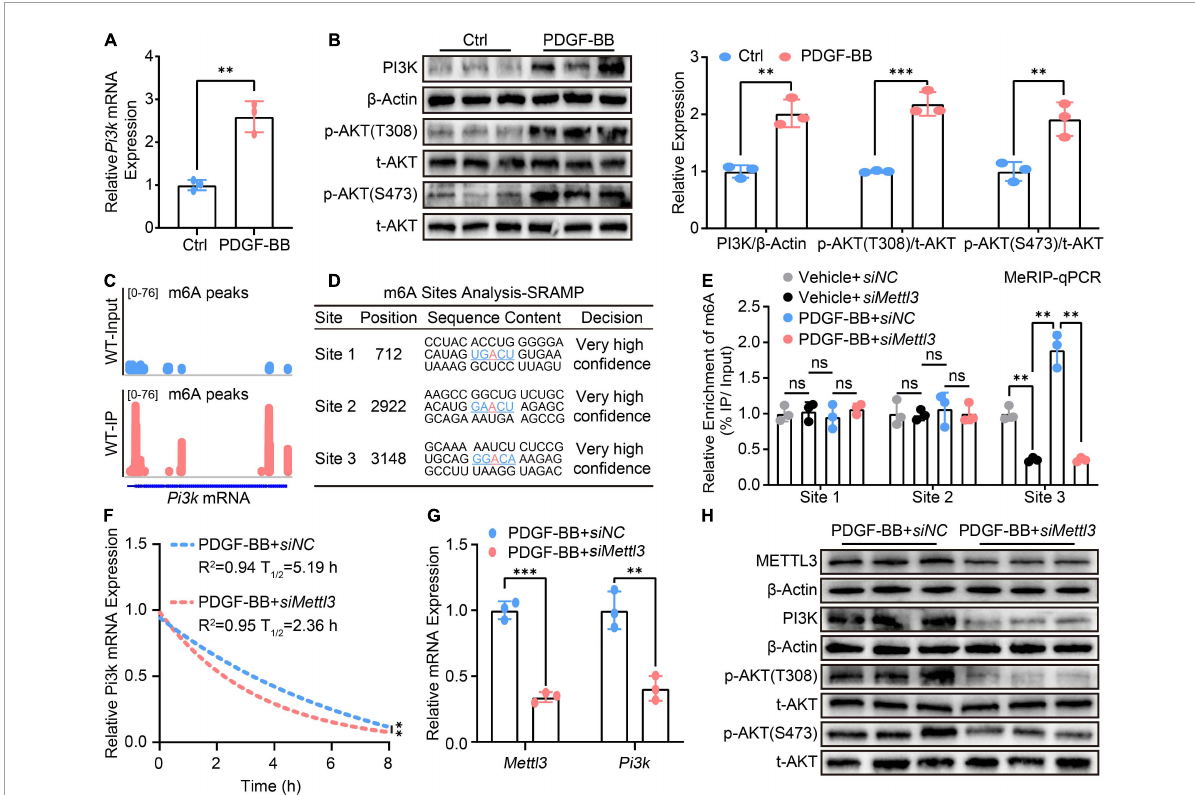
FIGURE4 Methyltransferase like 3 (METTL3)-mediated N6-methylatidine (m6A) deficiency promotes Pi3k mRNA decay thus inactivating PI3K/AKT signaling. (A) RT-qPCR quantification of Pi3k expression before and after treatment of VSMCs with PDGF-BB. (B) Representative Western Blot image and quantitative analysis of PI3K p-AKT(T308) and p-AKT(S473) levels. (C) Integrated genome browser (IGV) display of m6A peak distribute on Pi3k mRNA from the GES94148 dataset. (D) The m6A modification sites prediction results of Pi3k mRNA from the online SRAMP database. (E) MeRIP-qPCR quantitative analysis m6A fold enrichment of Pi3k mRNA detected by primers designed specifically for three sites predicted upon the transfection of siNC or siMettl3 . (F) Non-linear regression analysis of RT-qPCR showing the half-life of Pi3k mRNA. (G) Quantitative analysis of Pi3k mRNA expression. (H) Western Blot detection image of METTL3, PI3K, p-AKT(T308), and p-AKT(S473) proteins. All data were from three independent biological replicates and presented as mean ± SD. ∗ p < 0.05, ∗∗ p < 0.01, and ∗∗∗ p < 0.001 and ns indicates no